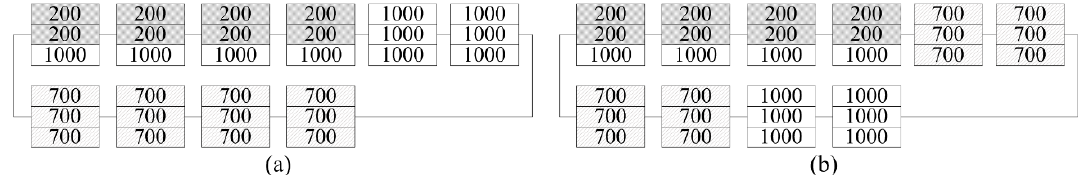
Figure 10 . Determination of possible configurations in Case 1.